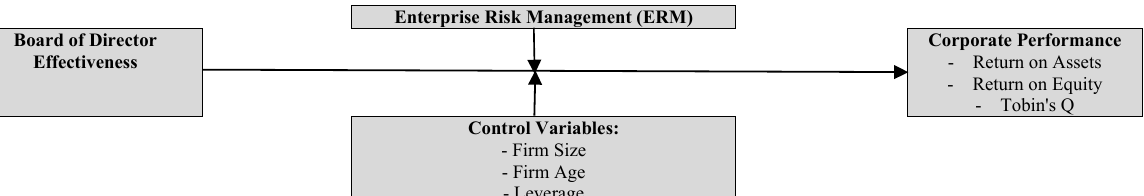
Fig. 1. The moderating effect of the ERM on the relationship between the BOD effectiveness on accounting and market performance in